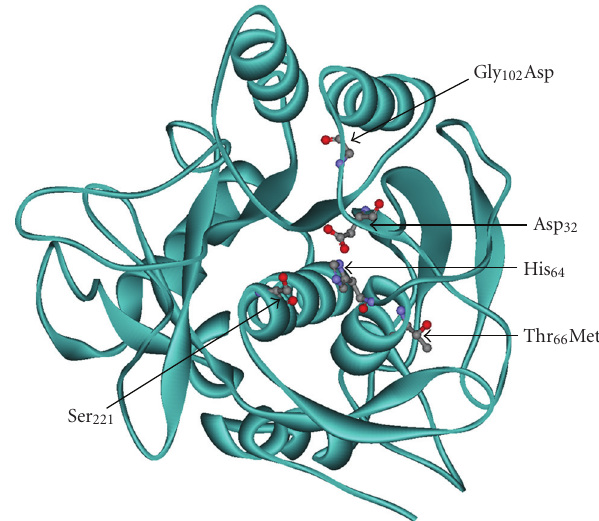
Figure 3: Thermal unfolding of subtilisin E . Fluorescence intensity unfolding data for wild-type AprE( (cid:2) ), AprE Δ L 75 –L 82 ( • ), and AprE Δ L 75 –L 82- T 66 M G 102 D ( (cid:3) ). The data were obtained with a heating rate of 1Kmin − 1 . Solid lines represent the best fit of unfolding data with Δ Hm = 233 . 3 ± 18 . 2 kJ mol − 1 and T m = 326 . 9 ±